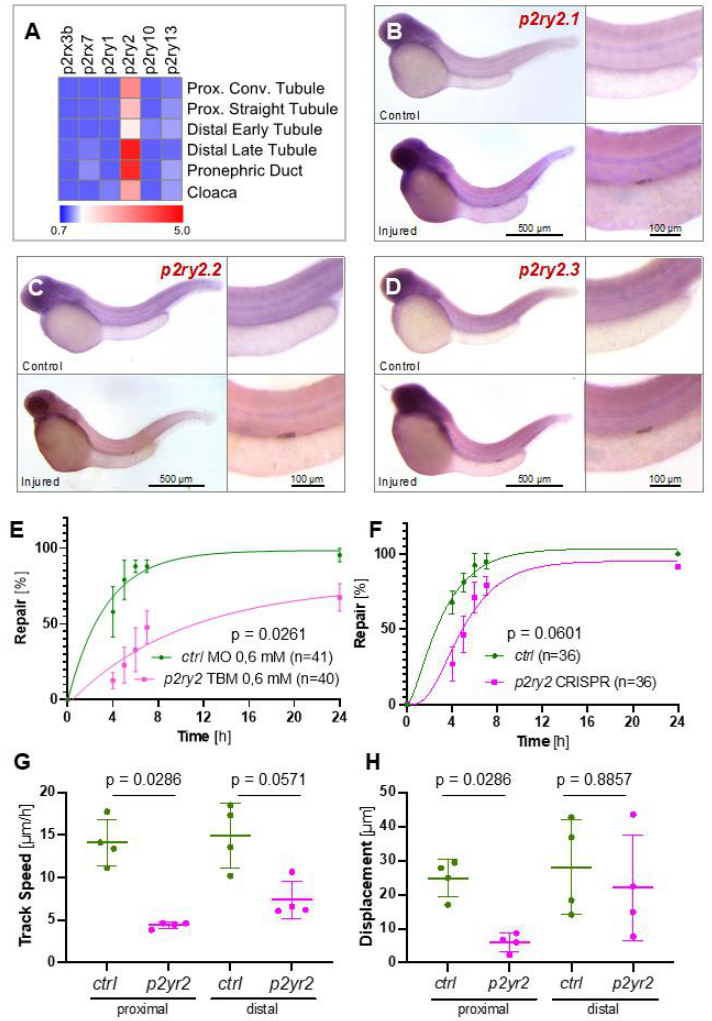
Figure 4. The involvement of purinergic P2ry2 receptors in zebrafish pronephros repair. ( A ) Single-cell RNA sequencing, performed with two-day-old zebrafish embryos, revealed expression of p2ry2 along the zebrafish embryo, while other P2 family members were expressed at low levels. ( B – D ) In situ hybridization revealed upregulation of all three zebrafish p2ry2 variants two hours after a laser-induced injury. ( E ) Depletion of zebrafish p2ry2.1, p2ry2.2 and p2ry2.3 by translation- (TBM) blocking morpholino oligonucleotides (MO) (each MO, 0.2 mM) significantly delayed the repair process. ( F ) Depletion of zebrafish p2ry2.1, p2ry2.2 and p2ry2.3 by CRISPR/Cas9 in combination with 8 sgRNAs delayed the repair process; however, the difference was statistically not significant (mean ± SEM; 2-way Anova). ( G , H ) High-resolution video microscopy revealed that p2ry2 depletion reduced track speed and cell displacement particularly in the proximal parts of the pronephros (mean ± SD; Mann – Whitney test).